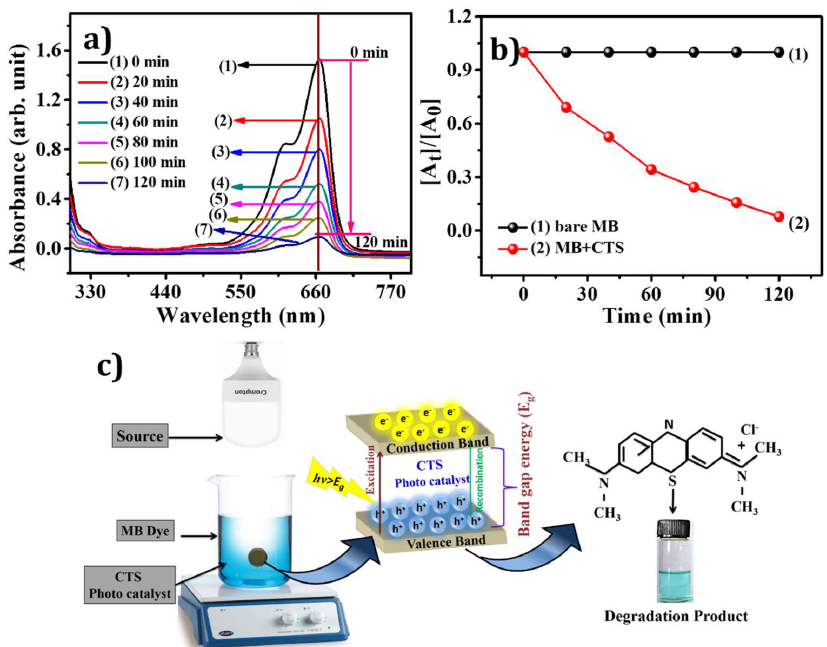
Figure 7. ( a ) UV-Vis absorption spectra of MB degradation with CTS as a catalyst, ( b ) plot of [ A t ]/[ A 0 ] as a function of radiation time for CTS nanoparticles, and ( c ) schematic representation of the possible photocatalytic degradation mechanism under visible-light irradiation with CTS as a catalyst. Similarly, the value of ‘ k ’ was found to be 0.0848 min −1 g −1 using Equation (4).